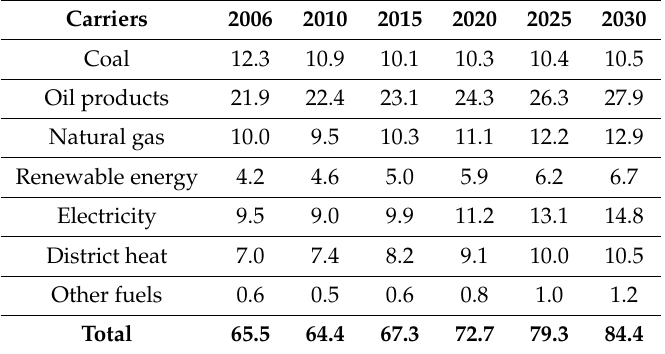
Table 2. Demand for final energy by carrier in Poland, Mtoe [15,26].